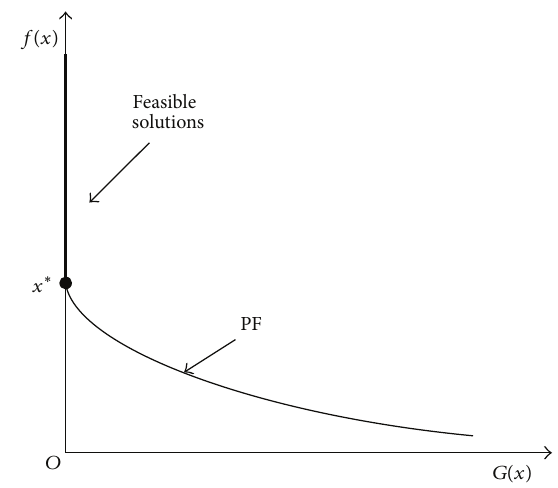
Figure 1: Relationship of solutions between COPs (1) and biobjec- tive problem